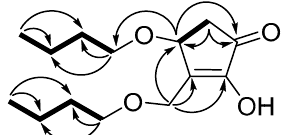
Figure 5. Selected HMBC (arrows) and 1 H- 1 H COSY (bold bond) Correlations of 2. The other compounds were identified as indole-3-carboxaldehyde ( 3 ) [26], 2,6-dimethoxy-1-anthracenecarboxaldehyde ( 4 ) [27], 7 β ,8 β ,11-triol-drimane ( 5 ) [28], 4-hydroxy-benzaldehyde ( 6 ), 4-hydroxybenzoic acid methyl ester ( 7 ), 4-hydroxy-benzoic ( 10 ), ergosterol peroxide ( 11 ) [29], 3 β ,5 α ,9 α -trihydroxy-ergosta-7,22-dien-6-one ( 12 ) [30] and adenosine ( 13 ) through a comparison of their experimental and reported spectro- scopic data. Table 1. The NMR Data of Compound 2 in CD 3 OD (600 MHz). Position